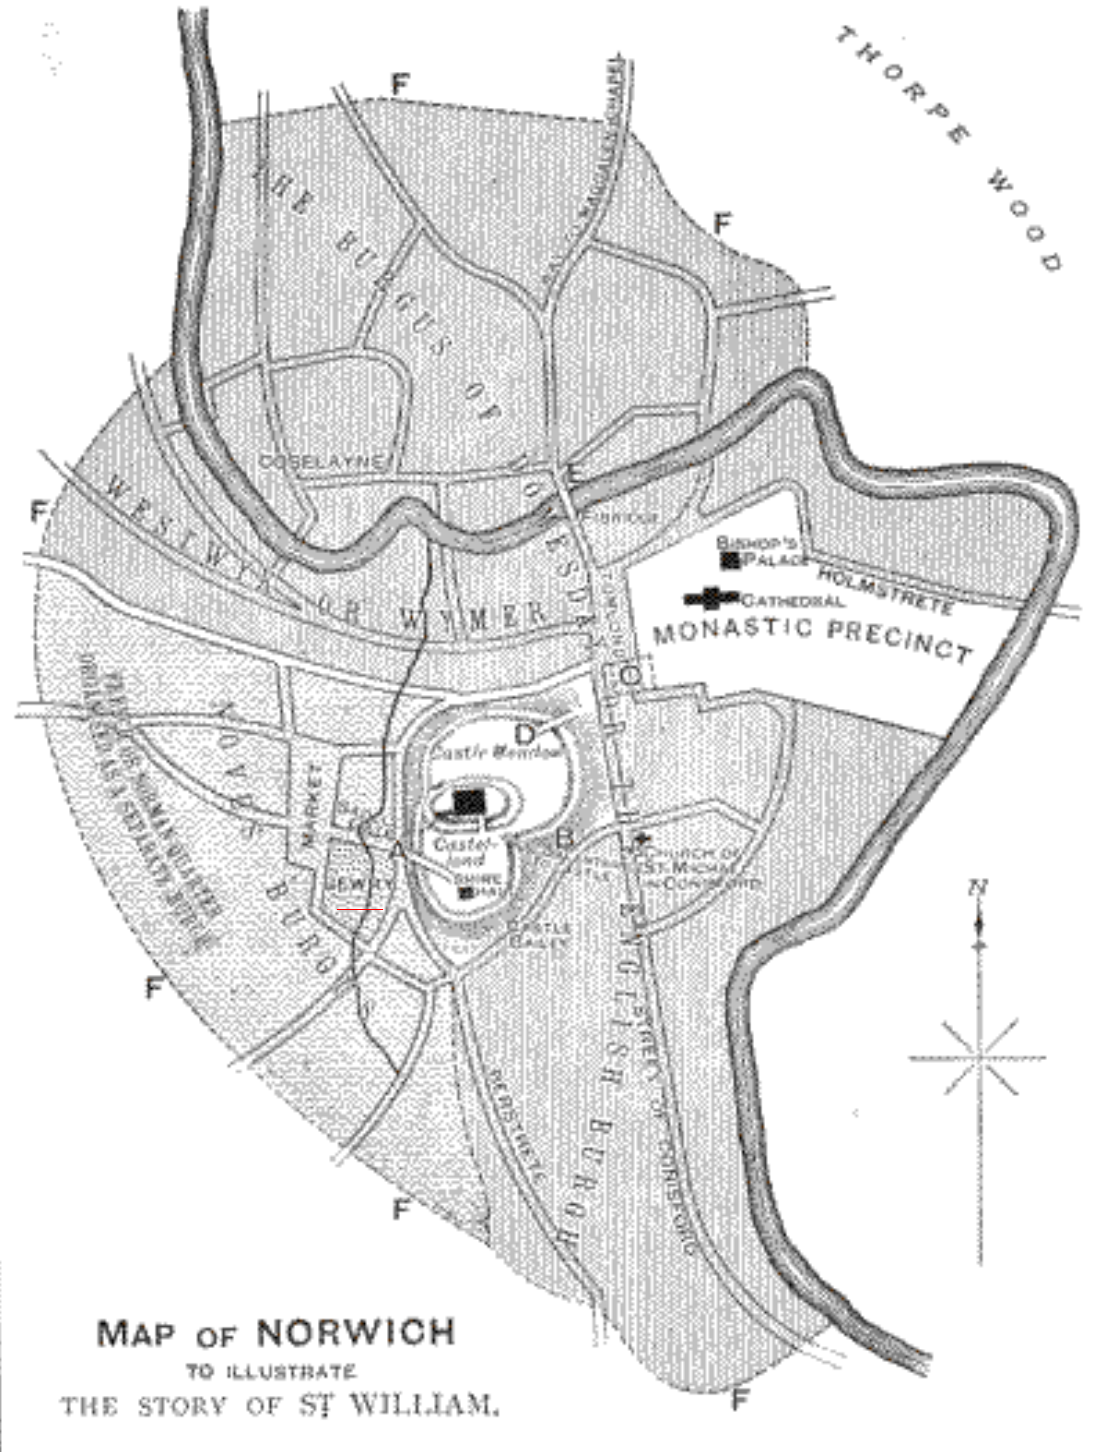
Figure 1: Map of Norwich,